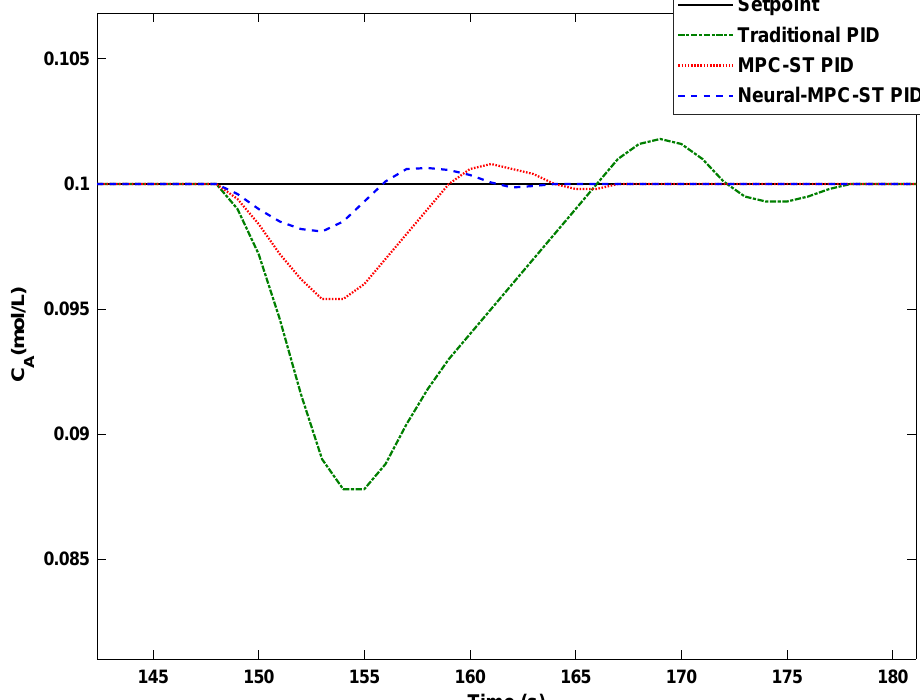
Figure 9. A closer look at a part of Figure 8.